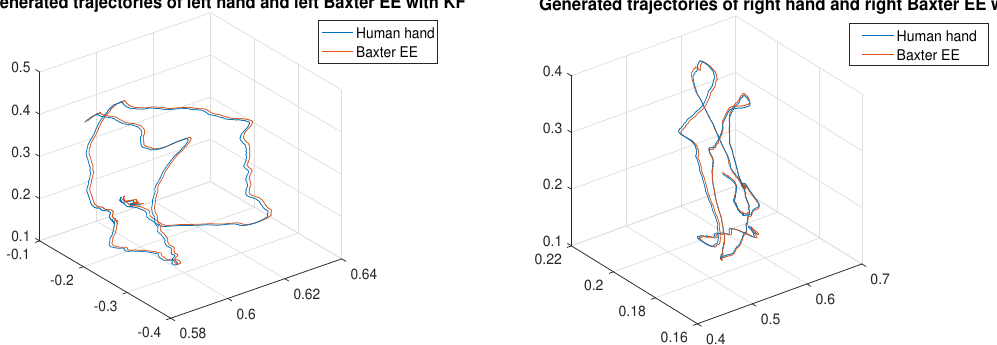
( a ) Left hand motion trajectories of human operator and Baxter end-effector without KF; Generated trajectories of left hand and left Baxter EE with KF